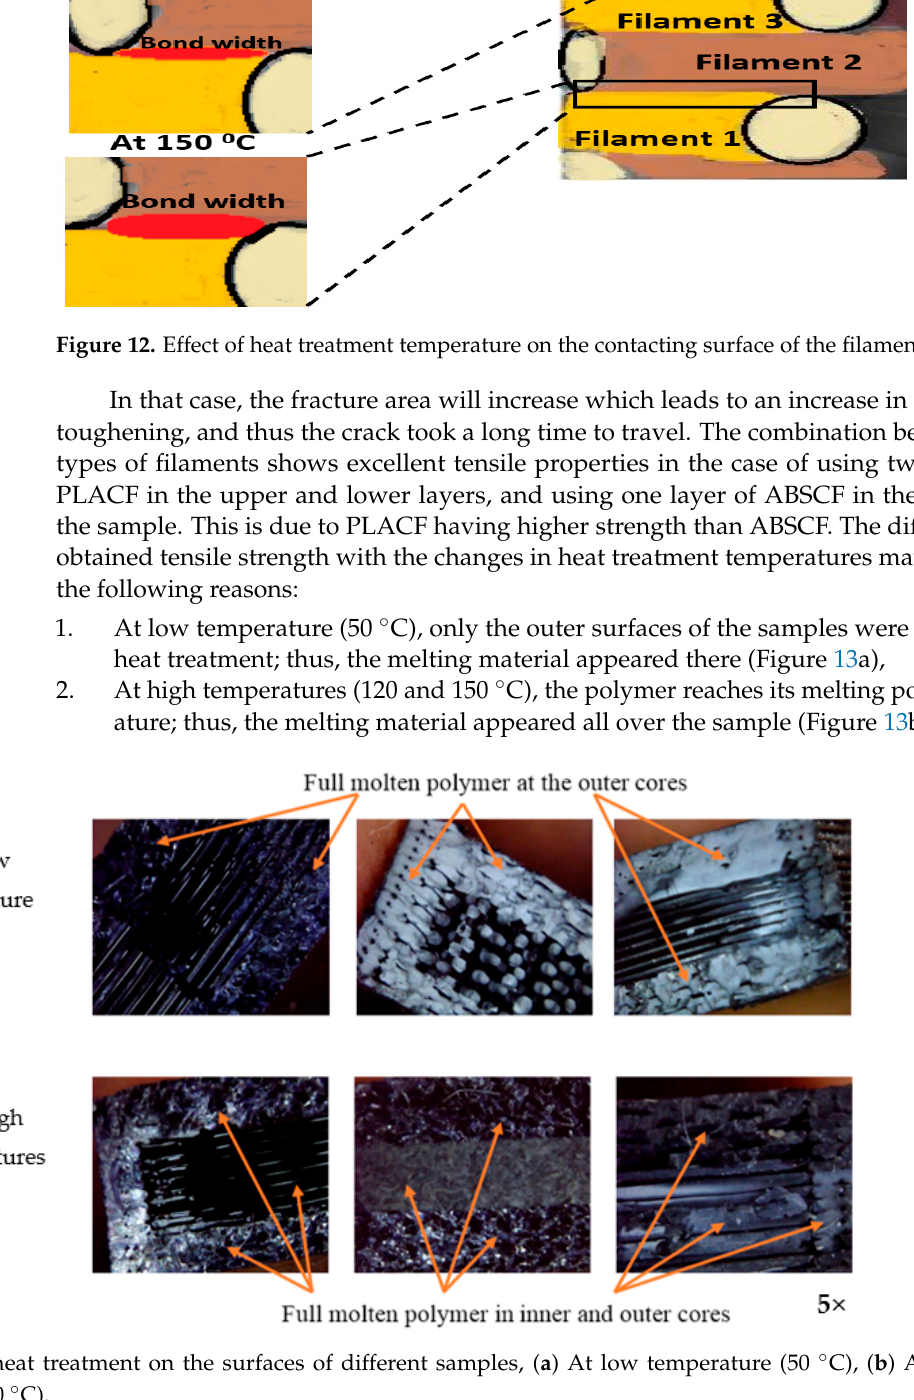
Figure 14. Effect of heat treatment temperature on types and locations of pores. 5. Conclusions In this work, the effects of the heat-treatment process on the physical and mechani- cal properties of 3D-printed samples using different types of filaments and with different pattern shapes and densities have been examined. Based on the experiments, the fol- lowing results could be mentioned •